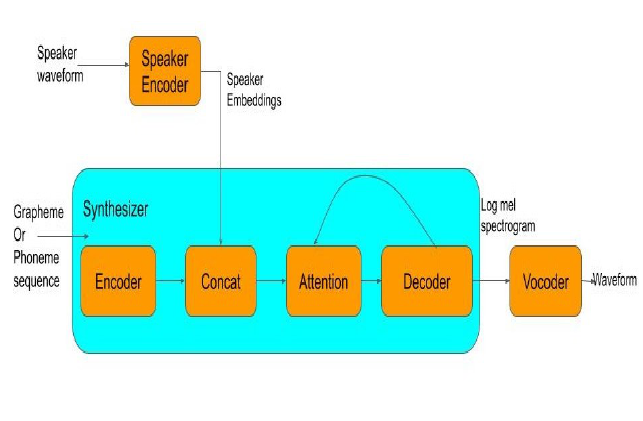
Figure 2. A General SV2TTS